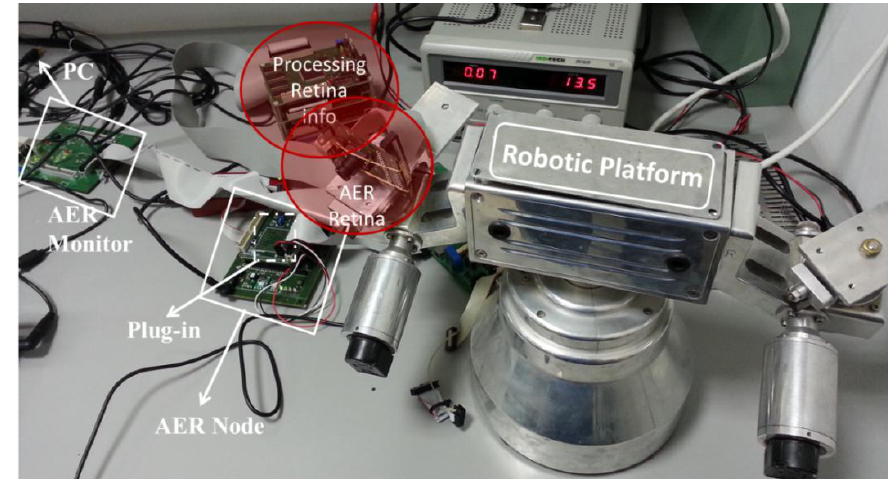
Figure 10. Setup designed to check the algorithm translation. Almost all the elements are shown. Behind the robotic platform is the actuation layer, where the spikes from the processing layer are received and transmitted to the motors.